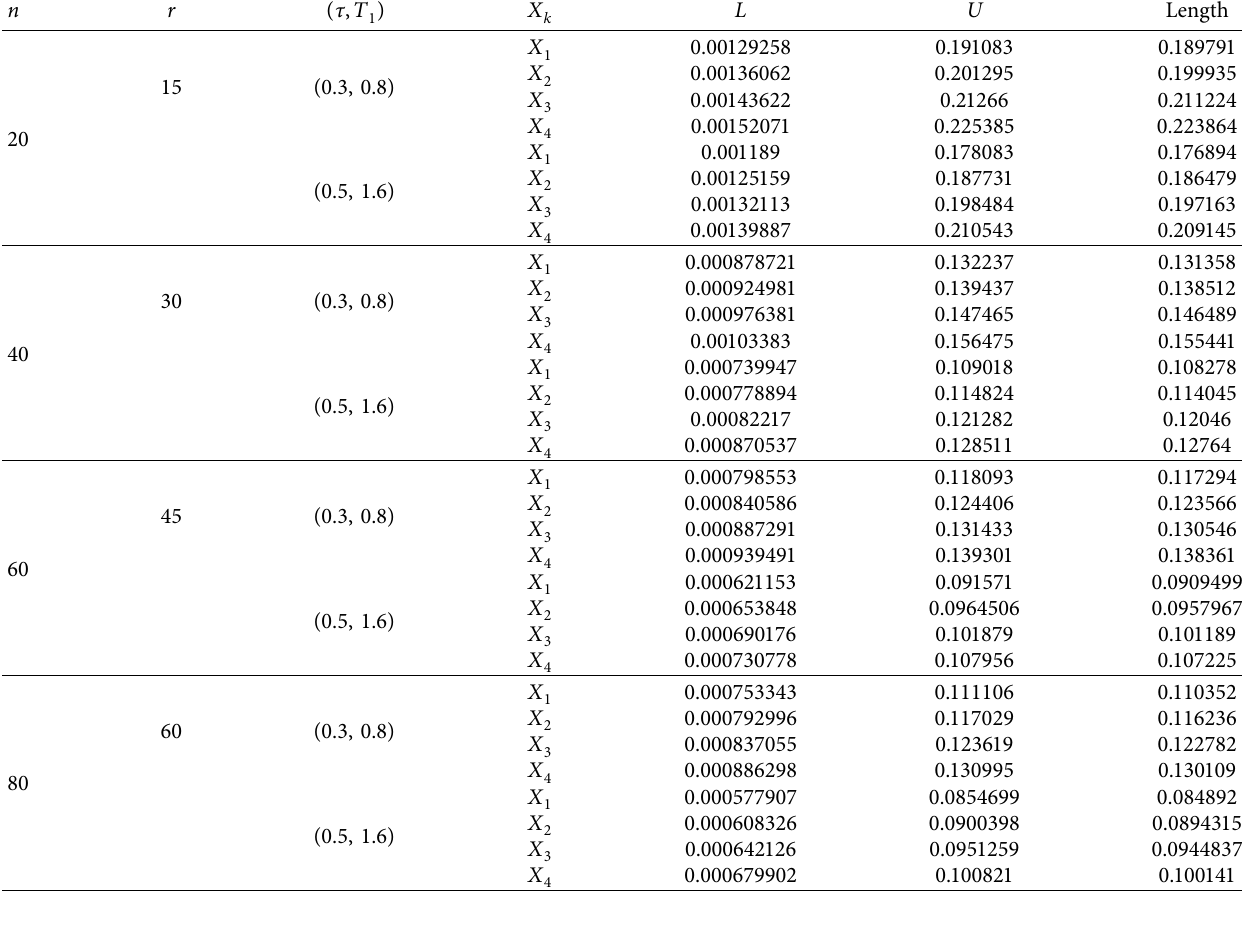
Table 2: 95% Bayesian predictive intervals of future order statistics when θ � 1 . 4, α � 1 . 8, and β � 2 . 5 a � 1 . 4, b � 0 . 8, c � 1 . 2, and d � 0 . 7 (two-sample